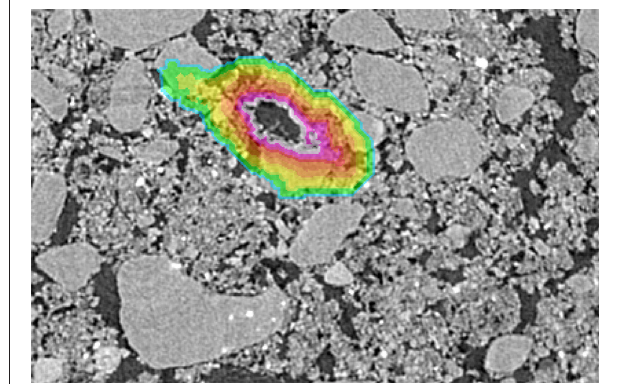
FIGURE 1 | Example of a selected root used for grayscale gradient analyses. The color overlay indicates the extent of the grayscale gradient with the colors indicating each individual 13 µ m